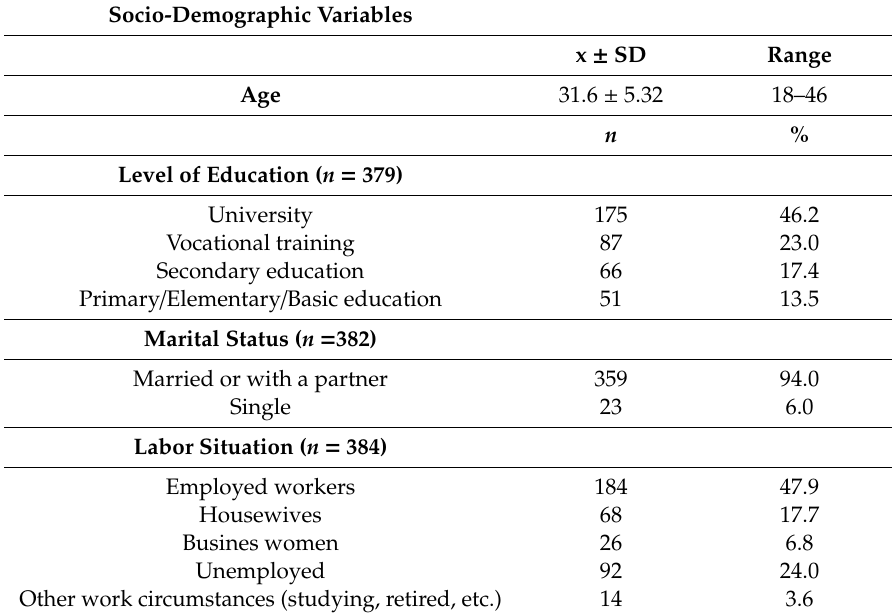
Table 1. Sociodemographic characteristics of the